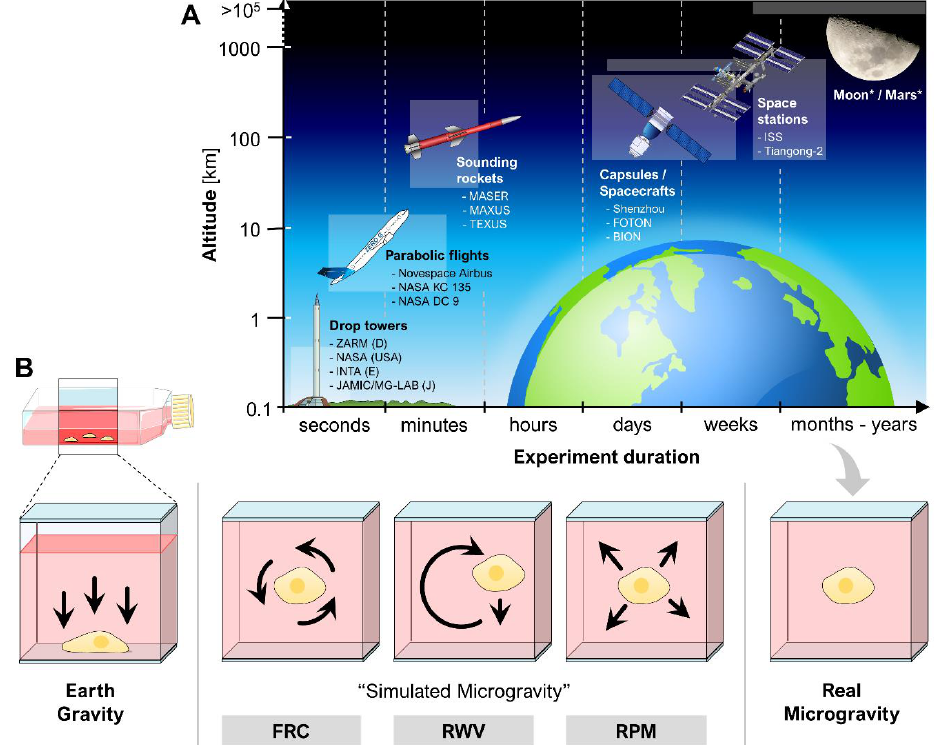
Figure 2. ( A ) Currently available and future (*) platforms for research in real µ g . The highlighted boxes indicate altitude and duration ranges of the experiments; ( B ) Different ground-based facilities to simulate µ g on Earth. Arrows indicate gravitational forces (Earth gravity) or movements to annulling gravity (“simulated µ g ”). Parts of the figure were drawn by using pictures from Servier Medical